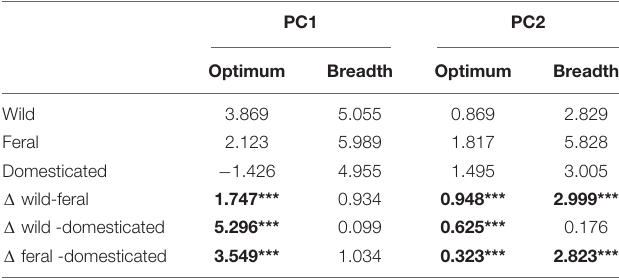
TABLE 4 | Niche optimum, breadth, and differences ( (cid:49) ) in both parameters among cotton groups. PC1 PC2 Optimum Breadth Optimum